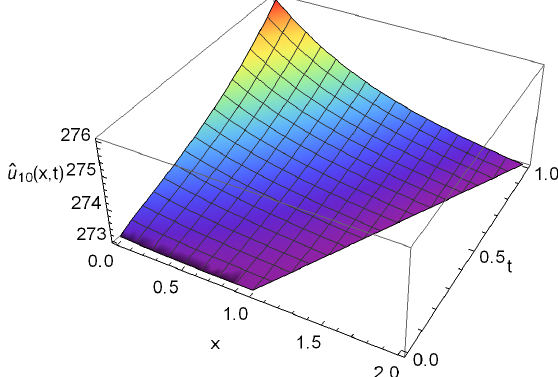
Figure 4. The reconstructed temperature distribution (cid:98) u 10 in the area Ω .